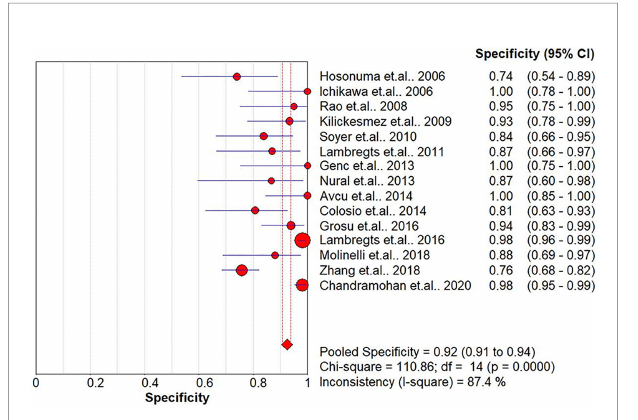
FIGURE 5 | Summary of the negative likelihood ratio of the included